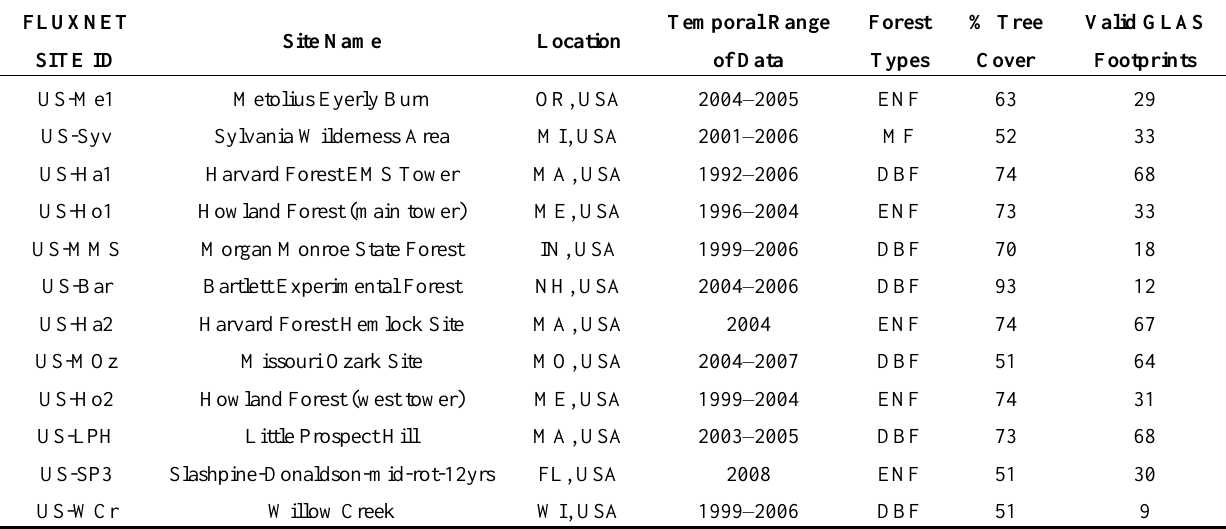
Table 3. The 12 FLUXNET sites selected for analysis in this study based on the distance between a site and valid GLAS footprints (≤10 km radius). The three dominant forest types at these sites are Evergreen Needleleaf Forest (ENF), Deciduous Broadleaf Forest (DBF), and Mixed Forests (MF). Percent tree cover values were derived from the MODIS VCF